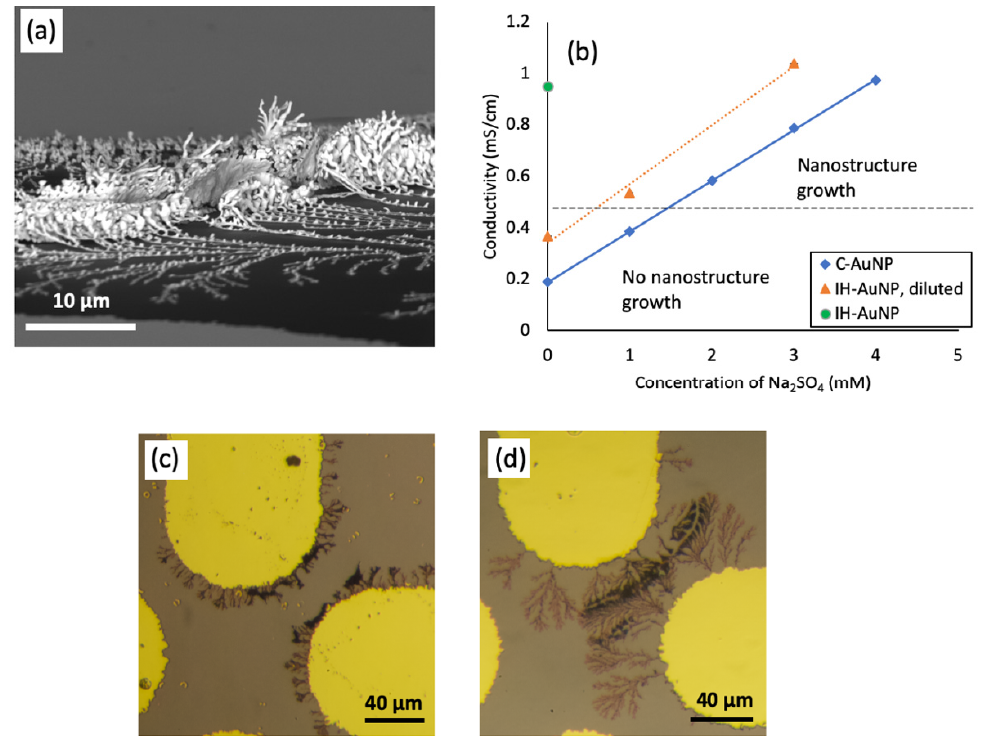
Figure 2. ( a ) A tilted SEM image of gold nanostructures grown at 10 kHz, 4.5 V. ( b ) The effects of medium conductivity (modulated via added sodium sulfate) on nanostructure growth (10 kHz, 4.5 V). Error bars are included on the conductivity values; all relative standard deviations were less than 1%. Points above the conductivity threshold (dashed line) resulted in nanostructure growth on the microelectrodes, whereas those below the dashed line resulted in no growth. ( c ) Cytodiagnostics AuNP nanostructures and ( d ) in-house AuNP nanostructures assembled above the conductivity threshold (10 kHz, 4.5 V).